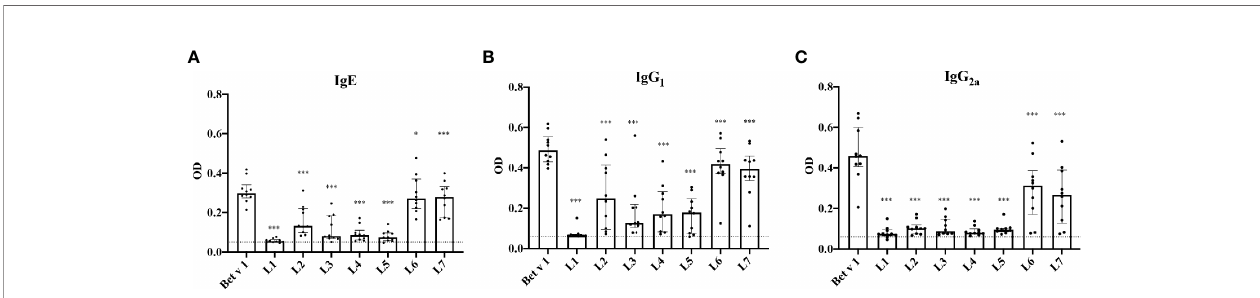
FIGURE 5 | IgE, IgG 1 and IgG 2a -recognition of Bet v 1 and Bet v 1 peptides in Bet v 1-sensitized BALB/c mice. Serum levels (optical densities, ODs) ( y-axes ) of Bet v 1- and peptides-speci fi c IgE (A) , IgG 1 (B) and IgG 2a (C) ( x-axes ) are displayed as scatter plots with medians and interquartile ranges. A group of 10 BALB/c mice was sensitized 3 times in intervals of 2 weeks with 10µg of Bet v 1 and ELISAs were performed with sera obtained 4 weeks after the last immunization. Data represent means of duplicate determinations performed for each mouse with a variation of less than 10%. Data were analyzed by a general linear model with a square root link, comparisons of peptides against medium control were done by Dunnett ’ s test. Statistically signi fi cant differences between Bet v 1 and peptides are indicated (***P < 0.001, *P < 0.05).